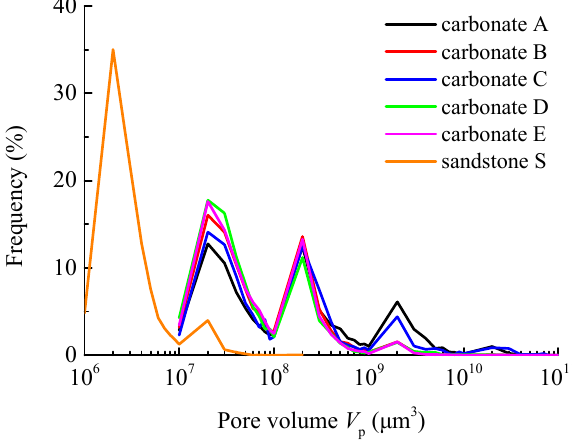
Figure 14. Distribution of pore volume in the REV2s of test samples.